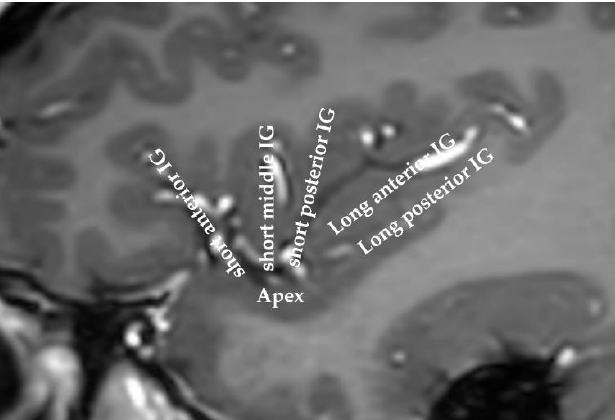
Figure 1. MRI of a human insula. The anatomy of the insula can be viewed on this sagittal slice . The insula is classically divided into the anterior insula and the posterior insula, which are separated by the central insular sulcus. IG: insular gyrus.